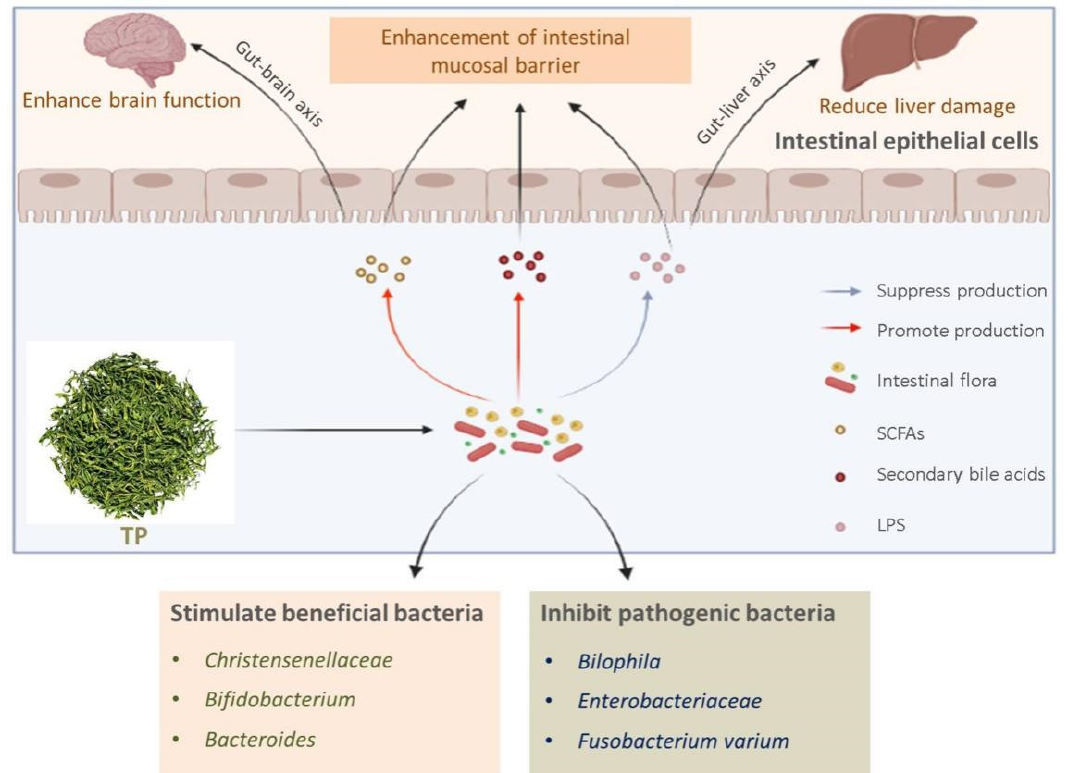
Figure 1. Effect of TP on intestinal flora.